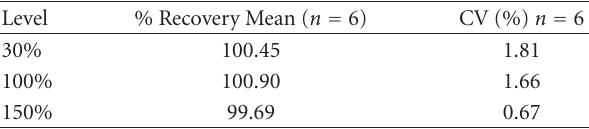
Table 3: Accuracy of the HPLC method for the determination of hederacoside C in Ivy-Thyme cough syrup placebo.